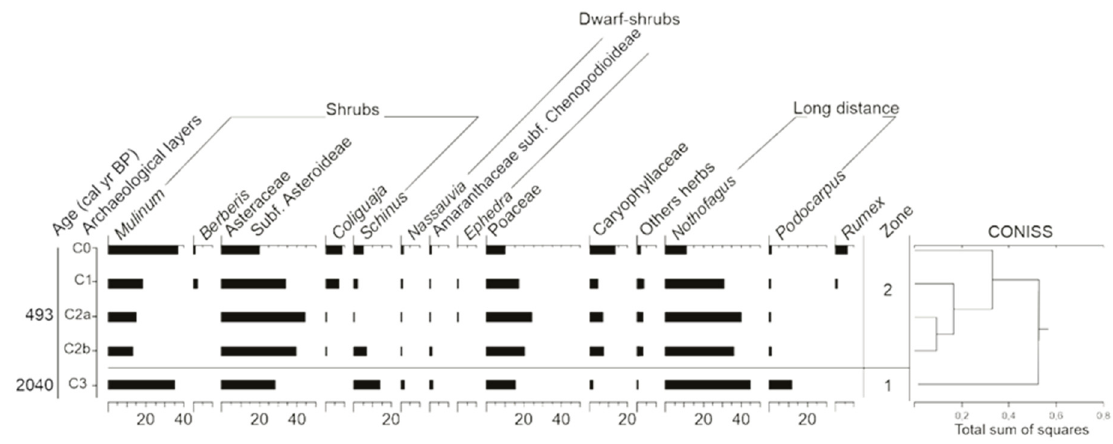
Figure 5. Pollen diagram in percentages (%) of the COCU archaeological sequence.